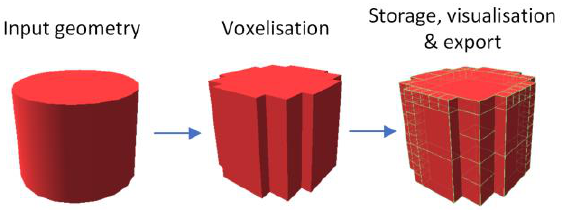
Figure 1 . Processing